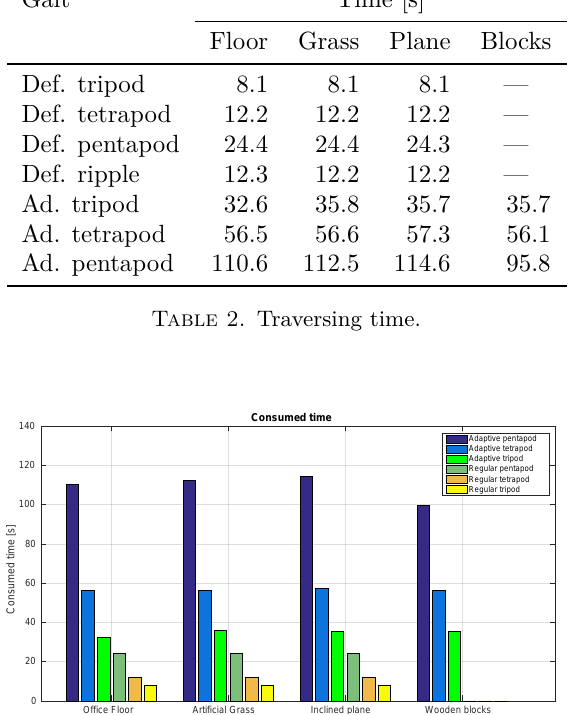
Figure 3. Energy consumption on different terrain types.